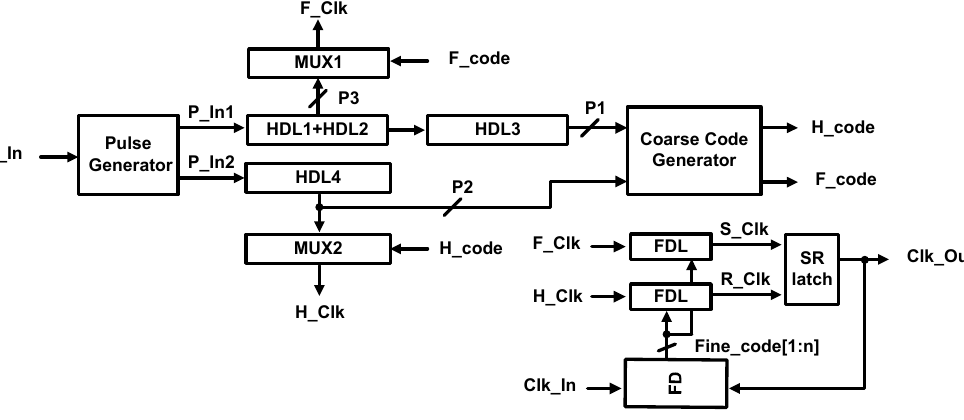
Figure 2. Block diagram of proposed circuit .